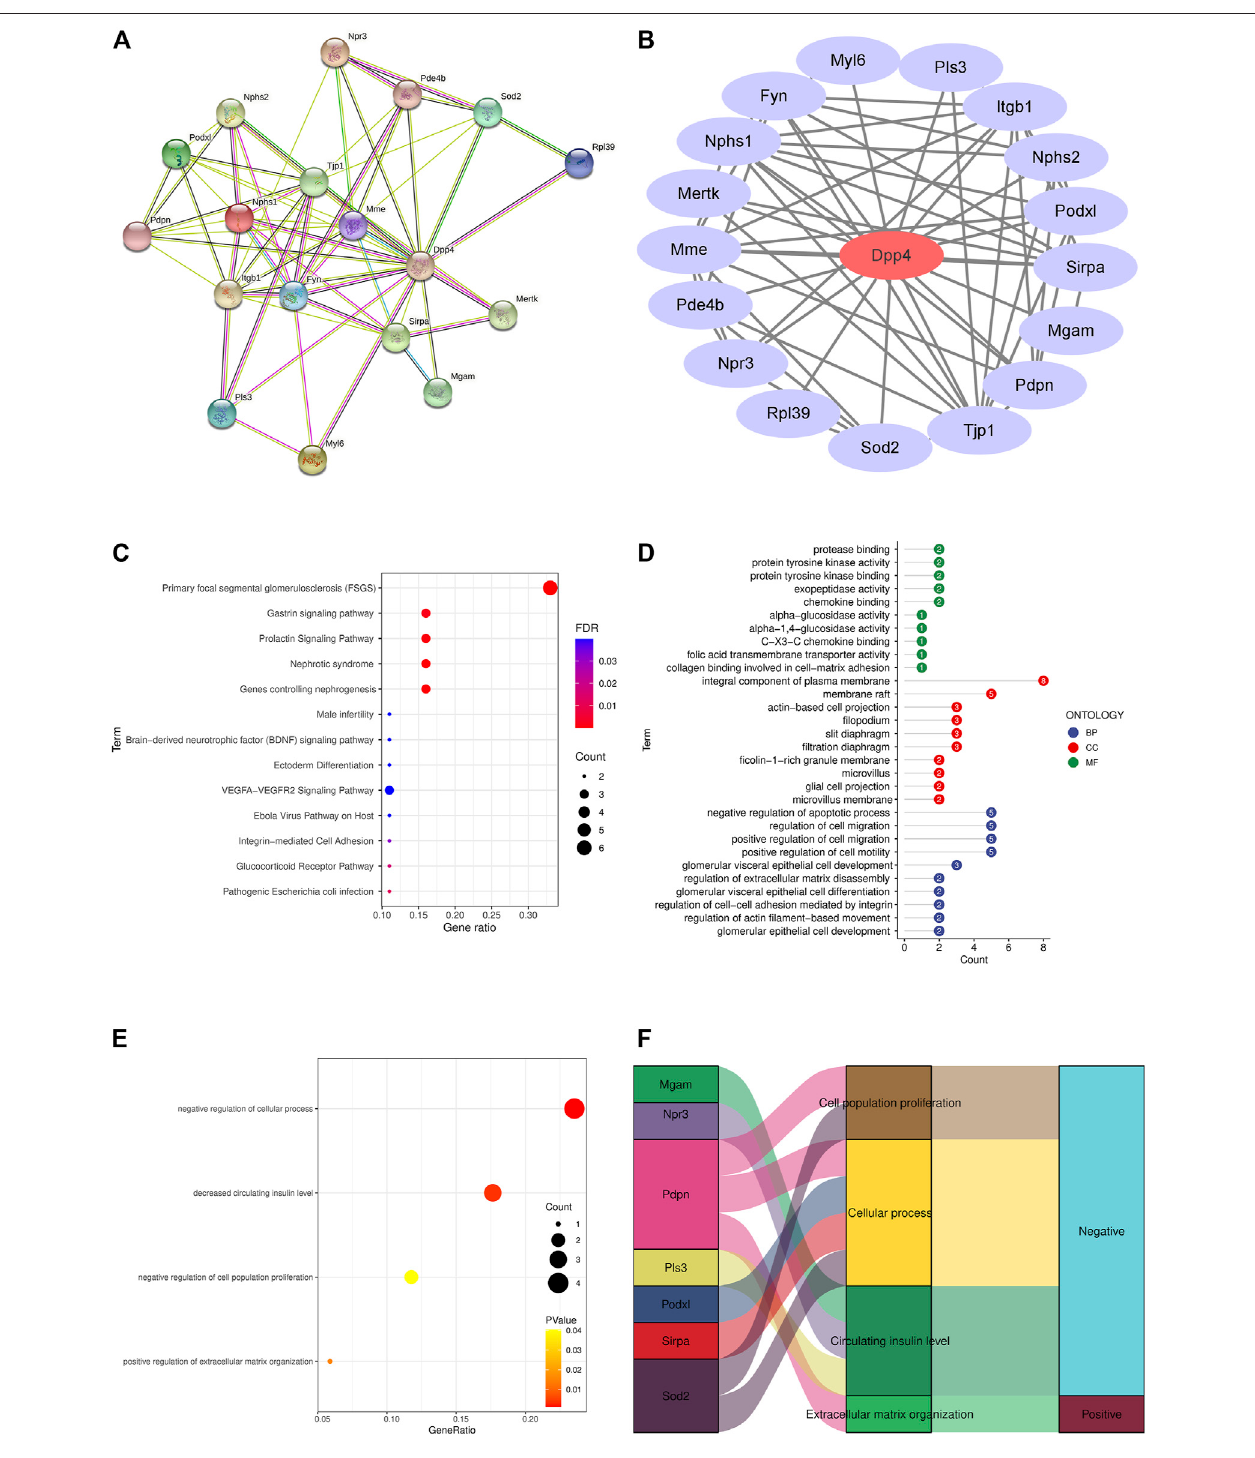
FIGURE 2 | PPI network and enrichment analysis of differential genes associated with Dpp4 in DKD podocytes. (A) Proteins predicted by the STRING online tool (https://string-db.org/) to interact with Dpp4 were signi fi cantly differentially expressed in DKD ( p < 0.05). (B) The PPI network, optimised by Cytoscape software, highlights the core position of DPP4 (red) with 17 differential genes (purple) at the periphery. (C) Enrichment of DKD podocytes differential genes in signalling pathways. (D) GO analysis of differential genes in DKD podocytes. (E) Screening for genes negatively associated with DPP4 function. (F) Sankey diagram showing the genes negatively associated with DPP4 function and the ontological functions in which they are involved.